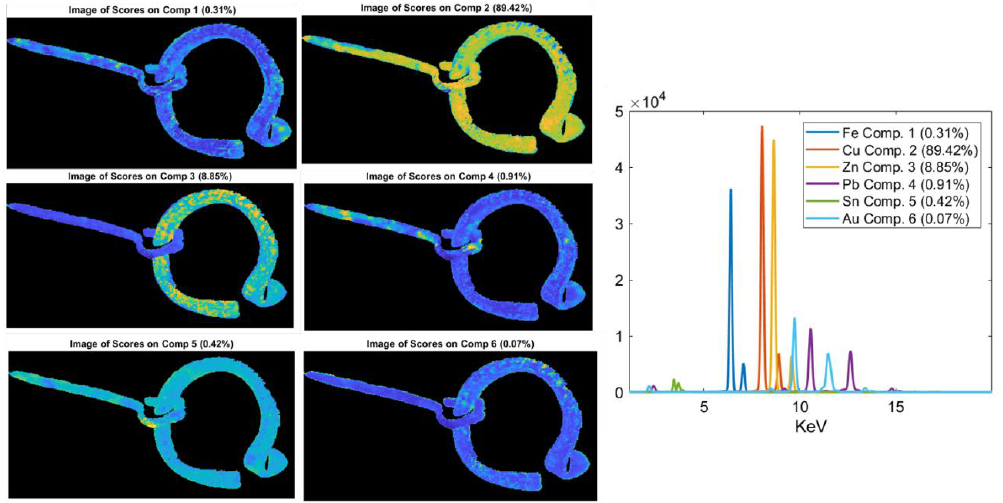
Figure 13. MCR analysis on the fibula 5123_45, the only one having the prong. Zn is uniformly distributed on the object’s surface (Comp. 3), while traces of gold are confirmed (Comp. 6), and a high Pb content is visible in the prong (Comp. 4).